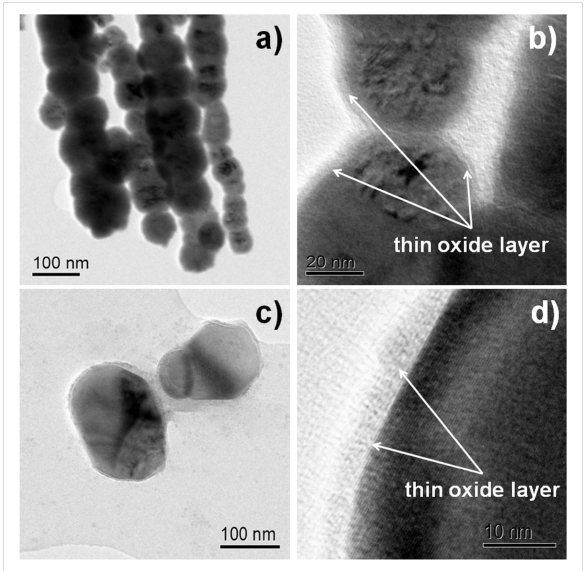
Figure 1: TEM images of a), b) iron nanowires and c), d) iron nanopar- ticles. Images b) and d) were recorded with high